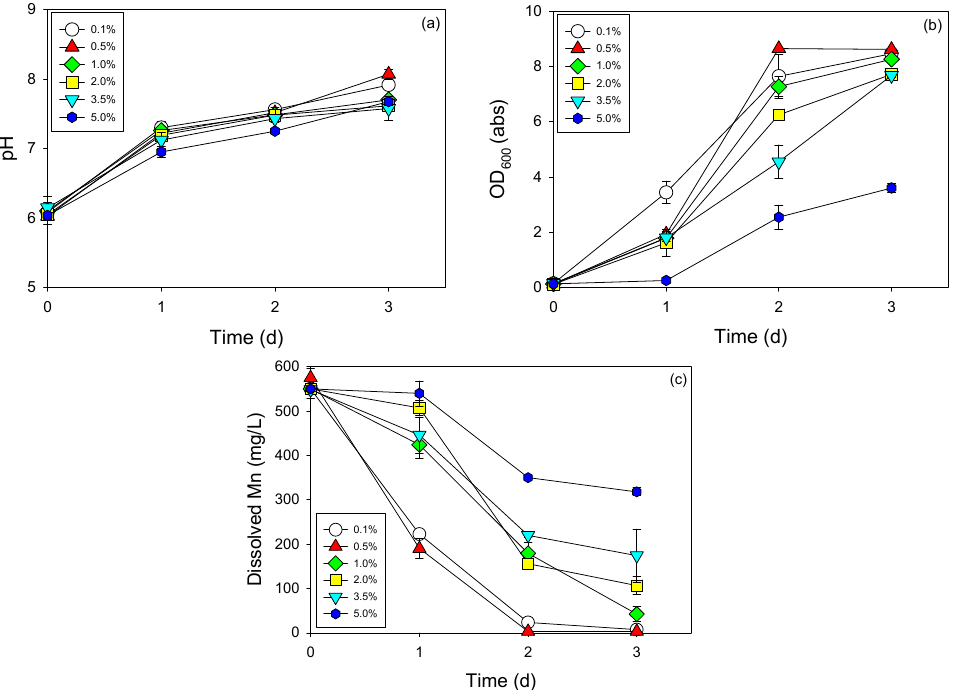
Figure 3. Manganese removal by strain NDMn-6 at various salinities. Changes in ( a ) pH, ( b ) optical density, and ( c ) dissolved Mn.